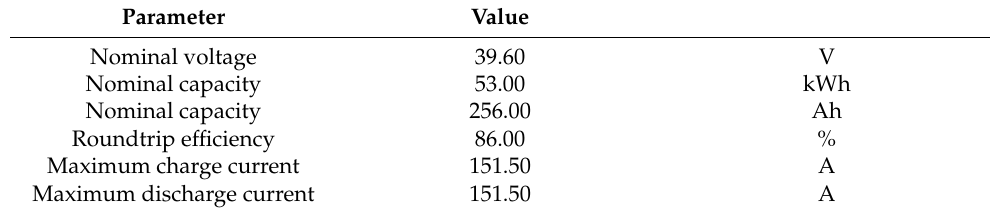
Table 4. Lithium-ion battery bank characteristics. Courtesy of HOMER